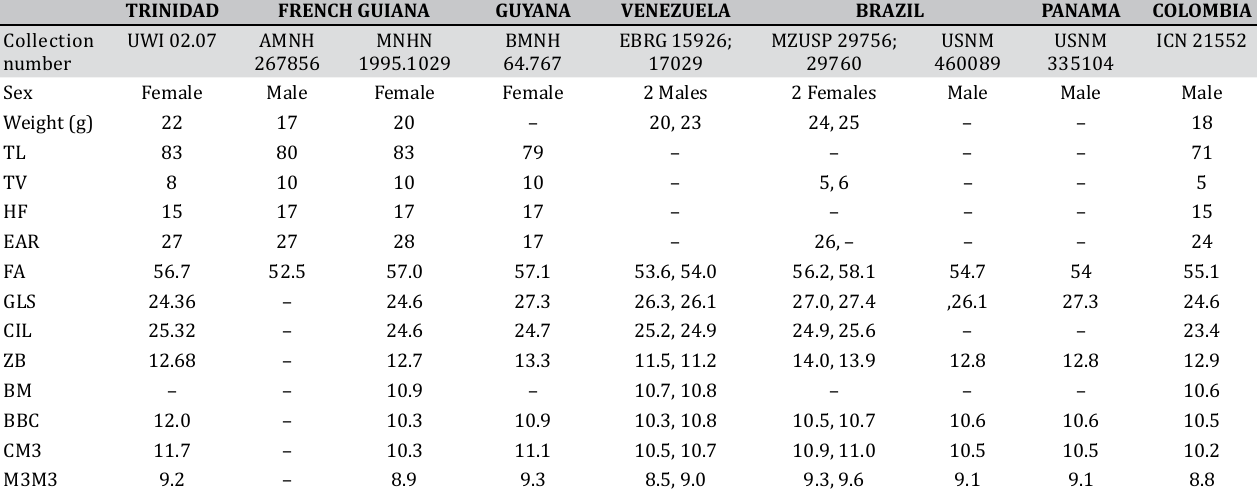
Glyphonycteris daviesi External and cranial measurements of the specimen of Guiana, Clark and Racey (2003) from Trinidad, and Gregorin and Rossi (2005) and Jones and Carter (1979) from Brazil. Measurements abbreviations are explained in the text. Collection abbreviations in the table: AMNH: American Museum of Natural History; BMNH: British Museum of Natural